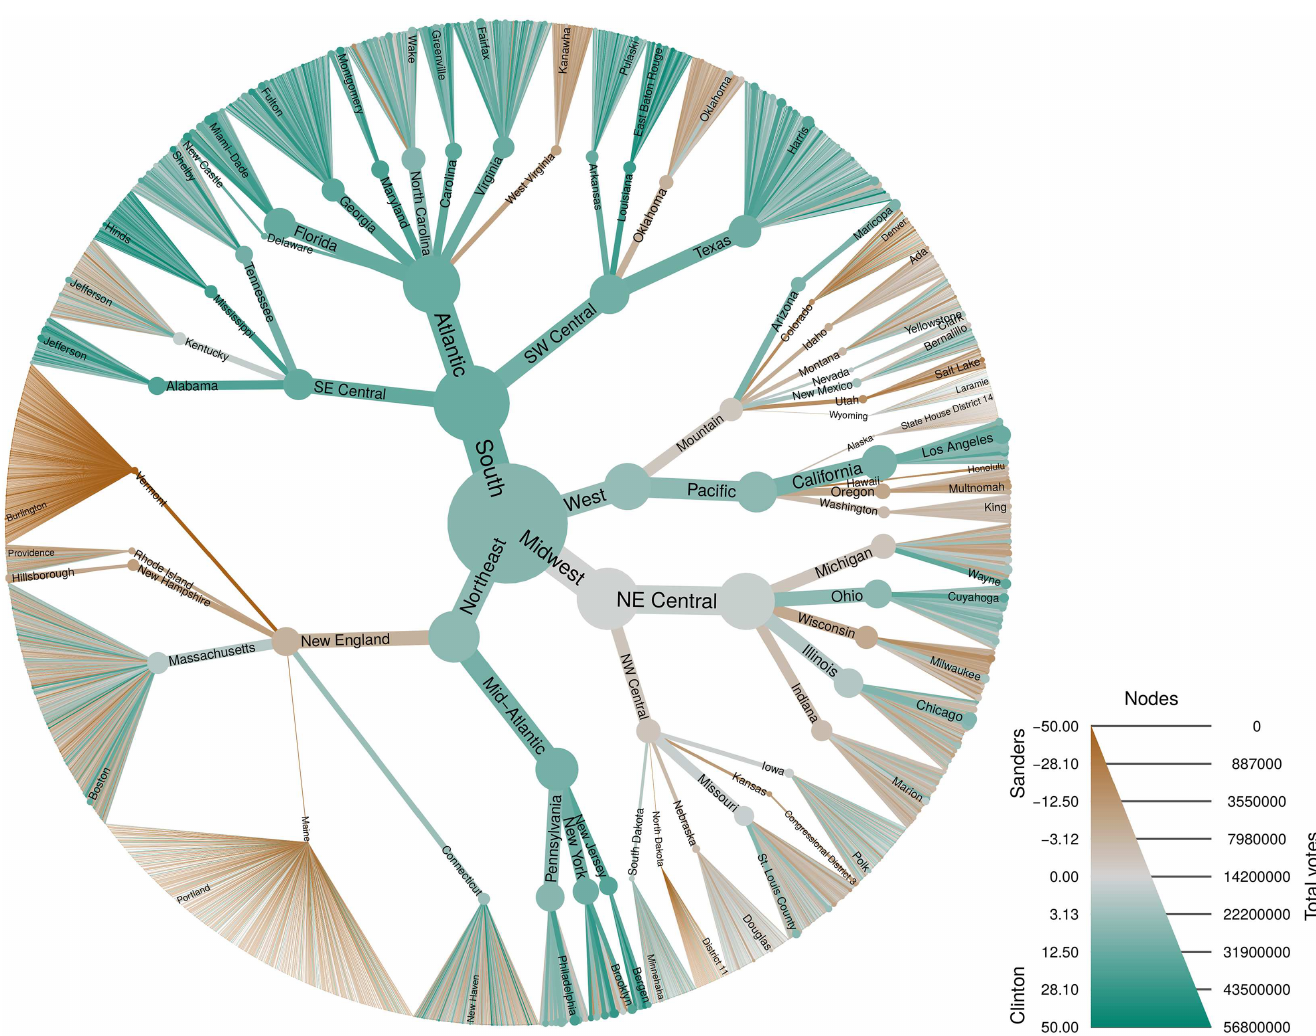
Fig 6. Metacoder can be used with any type of data that can be organized hierarchically. This plot shows the results of the 2016 Democraticprimary electionorganizedby region, division, state, and county. The regions and divisionsare those definedby the United States census bureau. Color corresponds to the difference in the percentage of votes for candidates HillaryClinton (green)and Bernie Sanders (brown). Size correspondsto the total numberof votes cast. Data was downloadedfrom